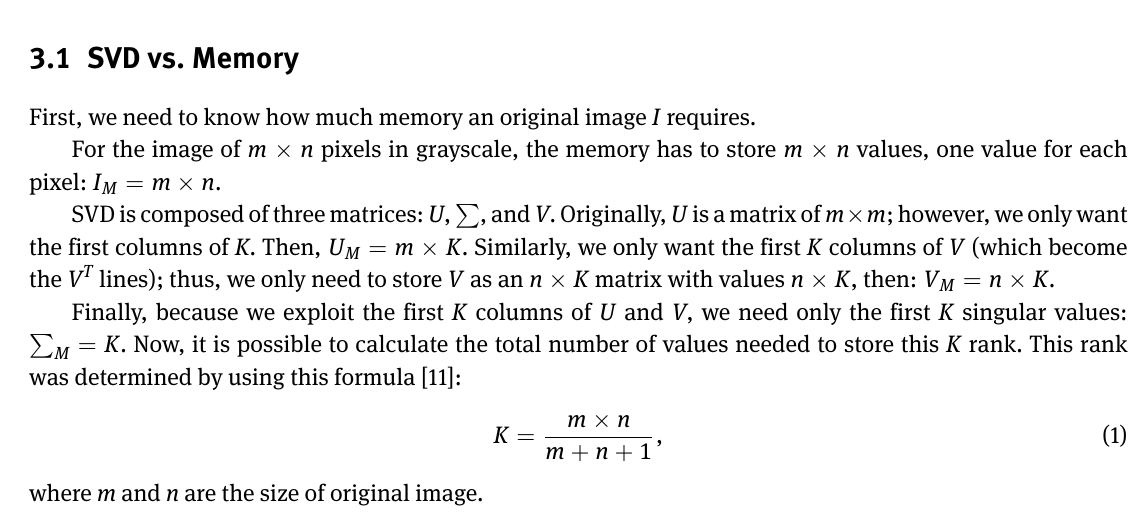
Figure 1: Decomposition of Matrix A